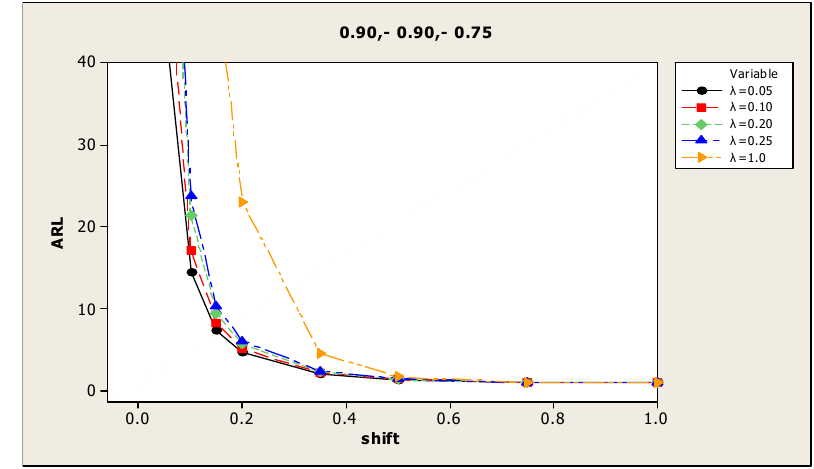
Figure 2. ARL curves when ρ yu = − 0.9, ρ yv = 0.9, ρ uv = − 0.75 at above values of λ .